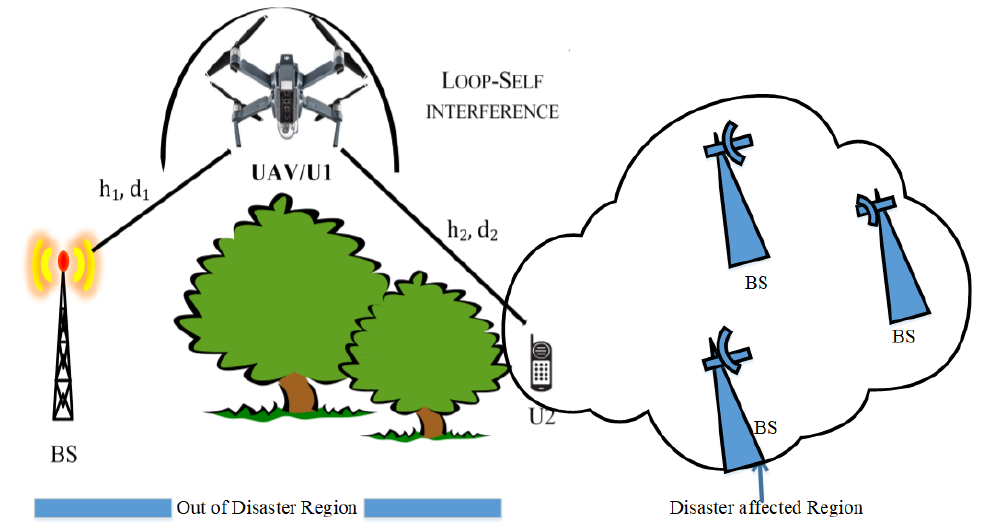
Figure 1. UAV-assisted downlink Co-operative NOMA cellular system in a non-direct link post- disaster